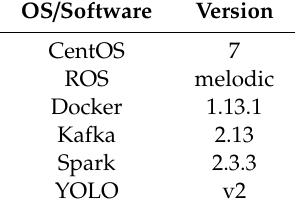
Figure 12. Message from ROS to the database.